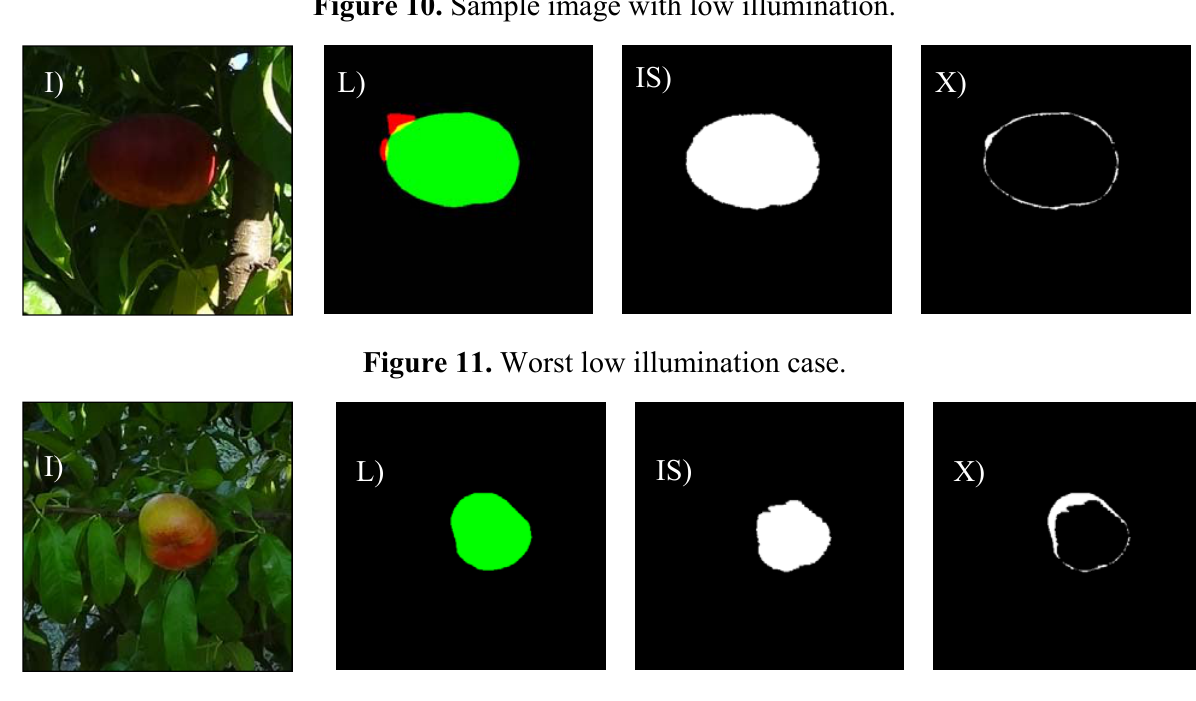
Figure 10. Sample image with low illumination.